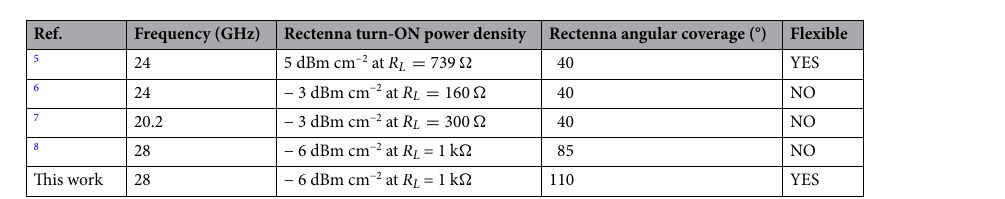
Figure 6. ( a ) Plot of the measured harvested powers by the rectenna with respect to the source’s incidence angle for the two DC combiners, rigid and flexible and ( b ) plots of the measured harvested powers and voltages with respect to the incident power density under different load conditions for the Rotman lens rectenna with and without the flexible DC combiner.